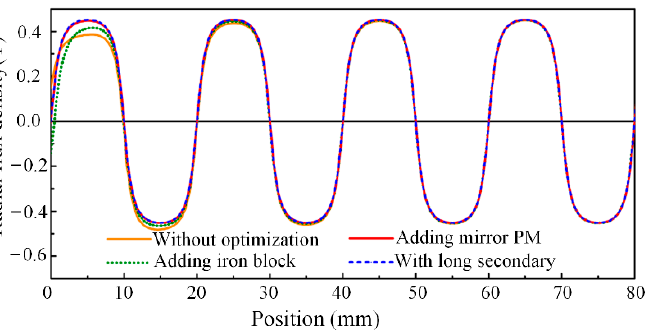
Figure 3. Waveforms of radial flux density with different optimization methods. Reprinted with permission from ref. [41]. Copyright 2018 IEEE